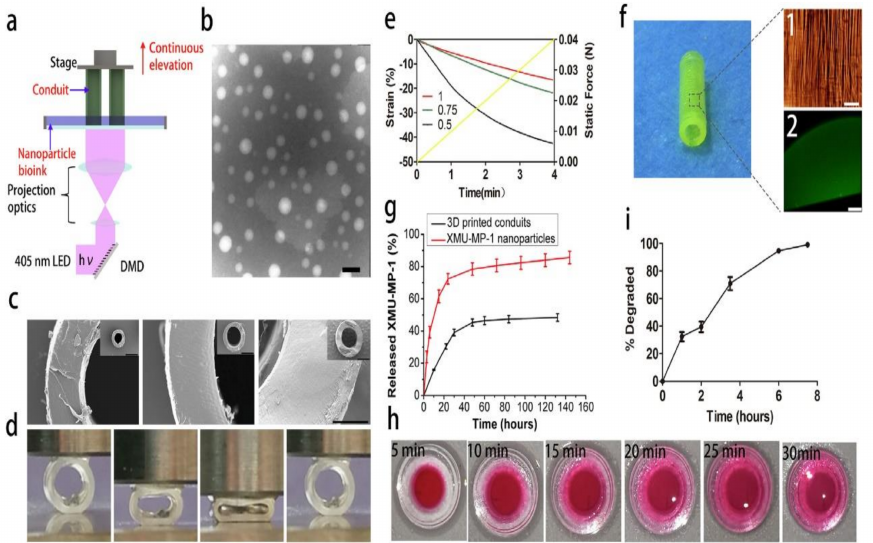
Figure 10. ( a ) Schematic diagram of a hydrogel catheter prepared with the DLP 3D printing method; ( b ) TEM image of XMUMP − 1 nanoparticles; ( c ) SEM images of 3D-printed conduits with differ- ent size. (Scale bar at the low magnification = 1 mm, scale bar at a high magnification = 200 lm). ( d ) The compression of the conduits with various wall thickness (0.5 mm, 0.75 mm, 1 mm) and the quantitative analysis ( e ). ( f ) The micro-structure (scale bar = 40 lm) (imaged by digital camera) and the nanoparticles distribution of the conduit (scale bar = 500 lm) (imaged by confocal microscopy). ( g ) In vitro release ofXMU-MP-1 from XMU-MP-1 nanoparticles and nanoparticle-enhanced con- duits. ( h ) The diffusion of small molecule in the conduits. ( i ) The degradation of the conduits in collagenase